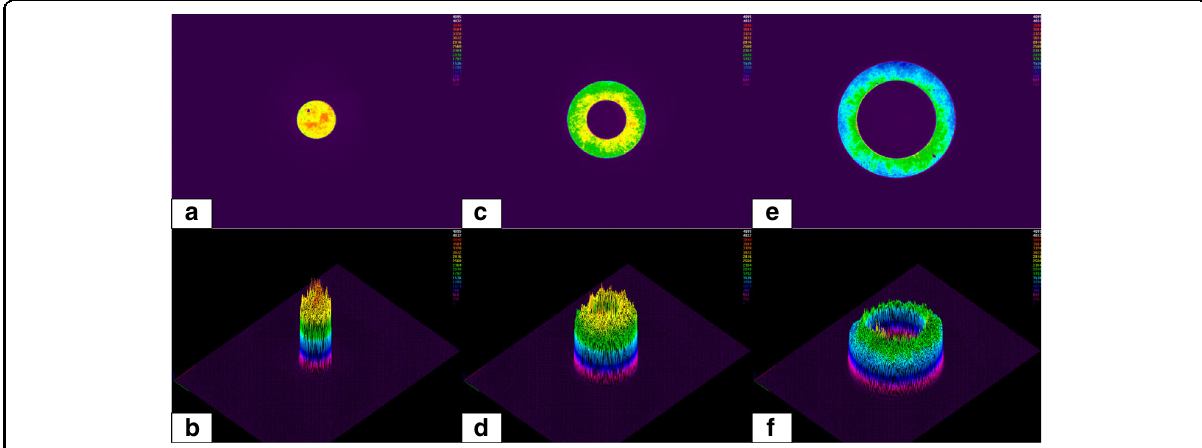
Fig. 10 Beam shaping of the original laser beam, the NA were 0.30 – 0.00, 0.60 – 0.30, and 0.95 – 0.60 from left to right